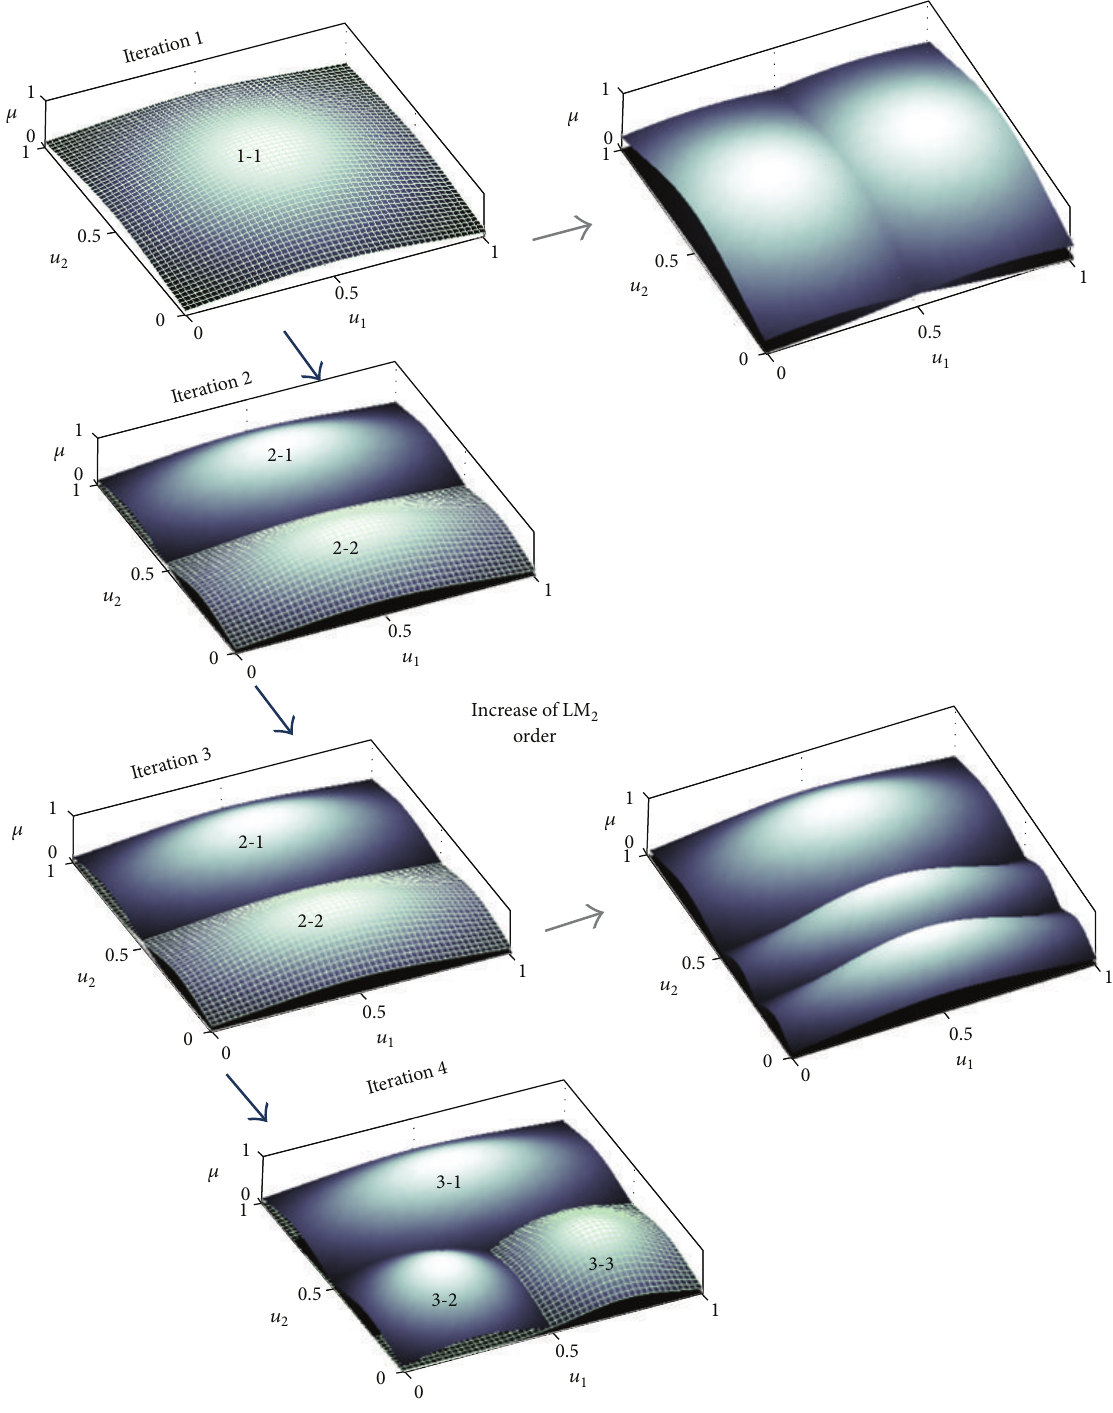
Figure 3: Operation of POLYMOT in the first four iterations in a two-dimensional